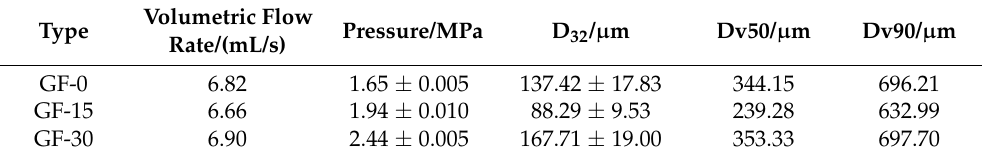
Table 2. The injection pressure and the mean droplet diameters of the DC nozzle for different gelled fuels.